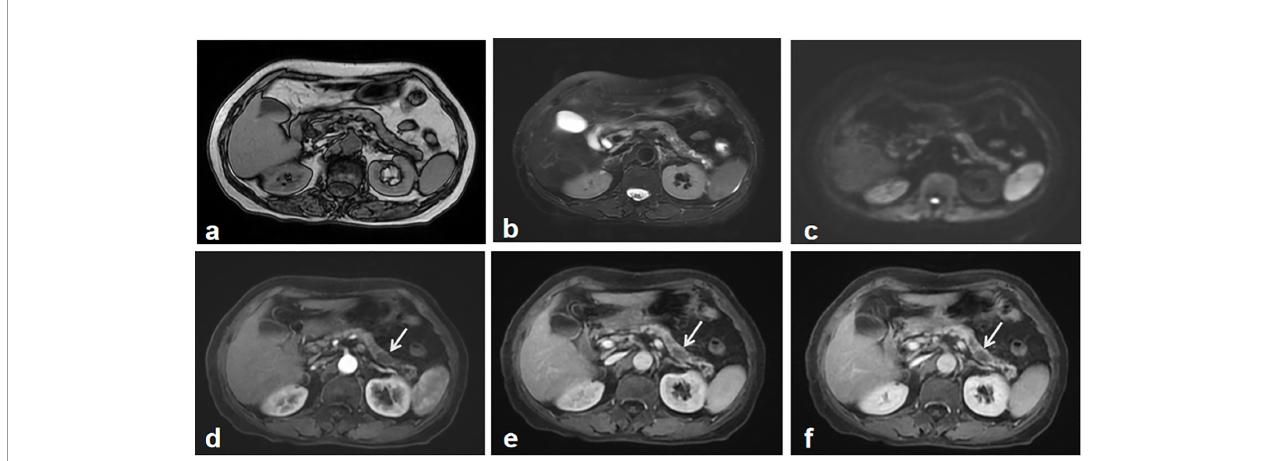
FIGURE 1 | The fi rst abdominal MRI. Both MR T1 (A) and T2 weighted image (B) showed the atrophy of the pancreas and inhomogeneous signal change in the body and tail of the pancreas. Diffusion weighted image didn ’ t show the apparent tumor mass-related signal change (C) . Gadolinium-enhanced T1 weighted images including early arterial phase (D) , late arterial phase (E) and portal phase images (F) , depicted multiple irregular hypointense signals without demonstrating a typical tumor imaging characteristics, which was regarded as an indeterminate lesion in the pancreas. A recommendation of imaging follow-up was made for the patient.